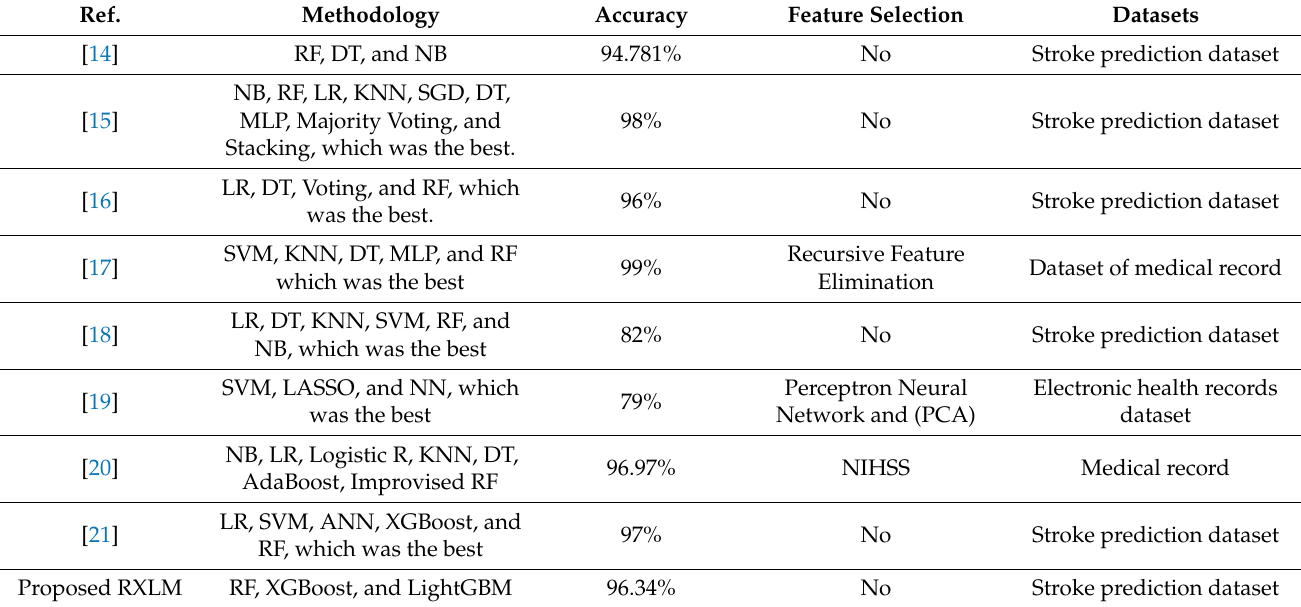
Table 7. Comparative results of the proposed RBSVM and recent ML